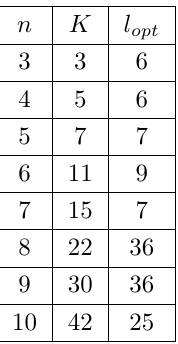
Table 1 . Table showing data for the optimal number of divisor sets to correctly determine the set of a for S . The table shows results for n = 3 up to n = 10 R n